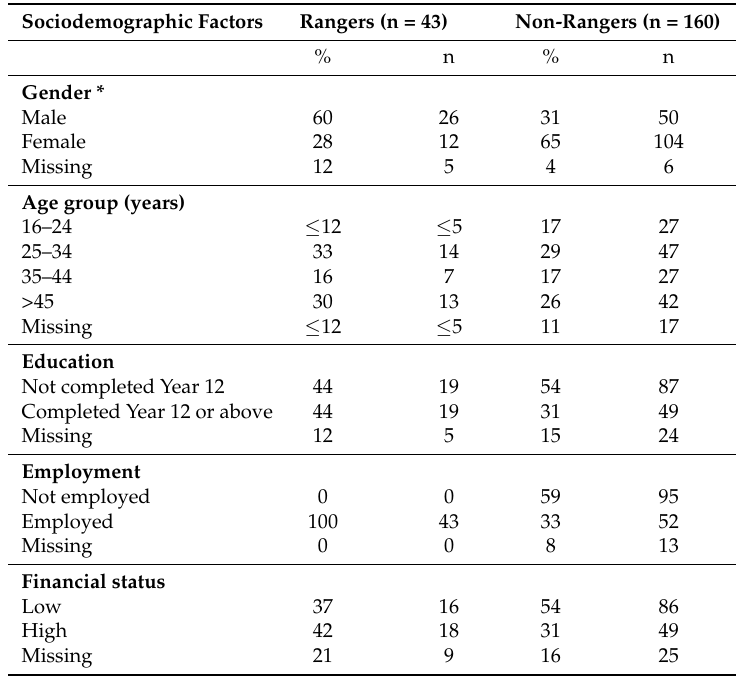
Table 1. Sociodemographic factors, by Ranger